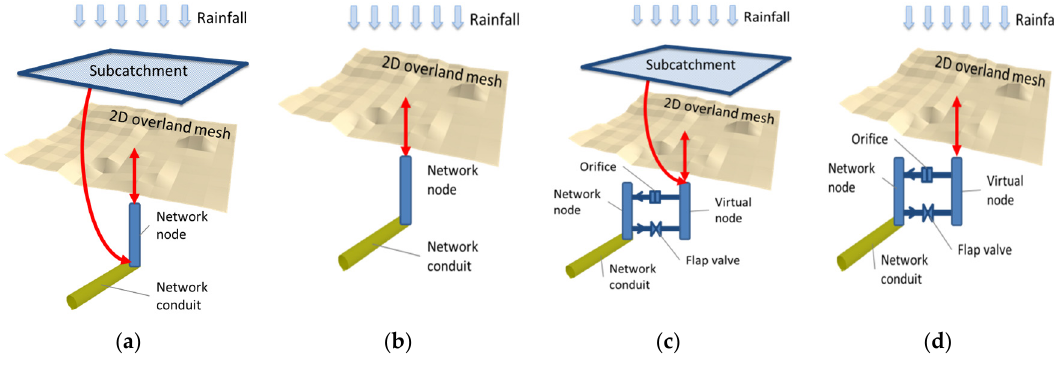
Figure 3. Connections of rainfall–runoff with overland and sewer flow modules: ( a ) traditional connections for SD models; ( b ) traditional connections for FD models; ( c ) developed connections for SD models; and ( d ) developed connections for FD models.